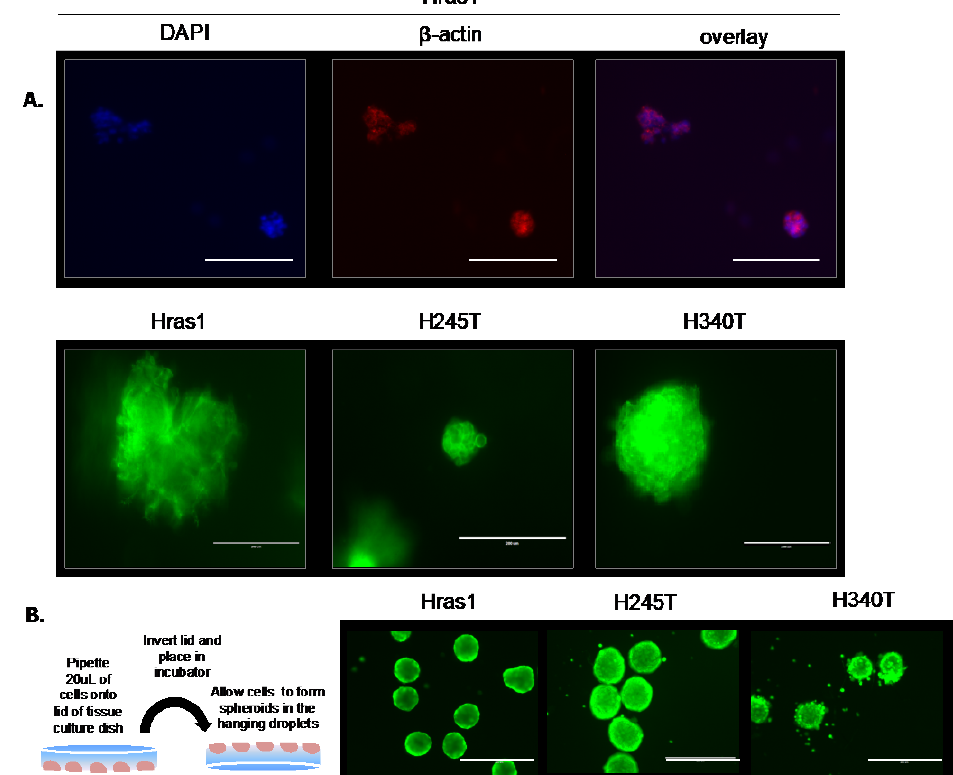
Figure 5. Development of physiologically relevant three-dimensional in vitro tumor models. ( A ) Representative images of Hras G12V /Pten −/− /TPO Cre cell lines (Hras1, H245T, H340T) grown embedded in Matrigel to produce 3D spheroids. Spheroids were fixed and stained for β -actin and counterstained with DAPI (top) or stained with fluorescently conjugated phalloidin antibody (bottom). Scale bars represent 200 µm. ( B ) Left: Schematic depicting process by which spheroids in hanging droplets are generated. Right: Spheroids collected after 7 days were labeled with Calcein-AM to assess viability. Scale bars represent 400 µm. Images are representative of three independent ex- periments.